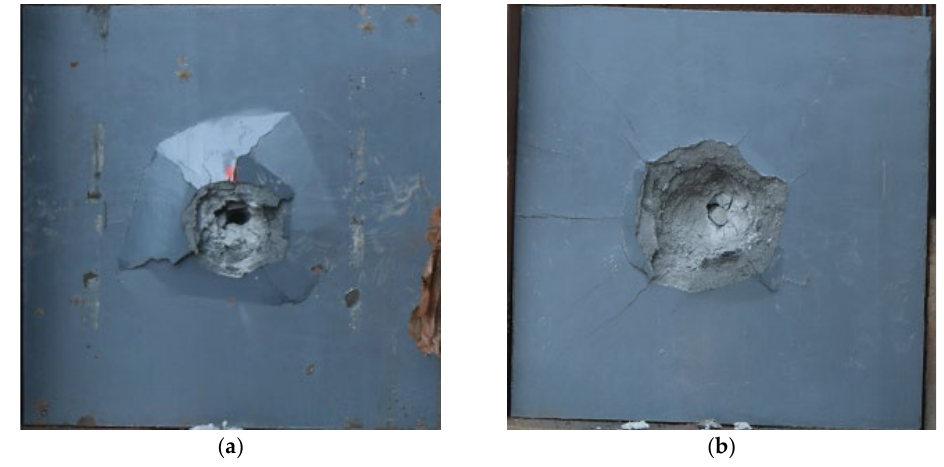
Figure 7. Frontal damages of UHPC targets: ( a ) U-1 target; ( b ) U-2 target.